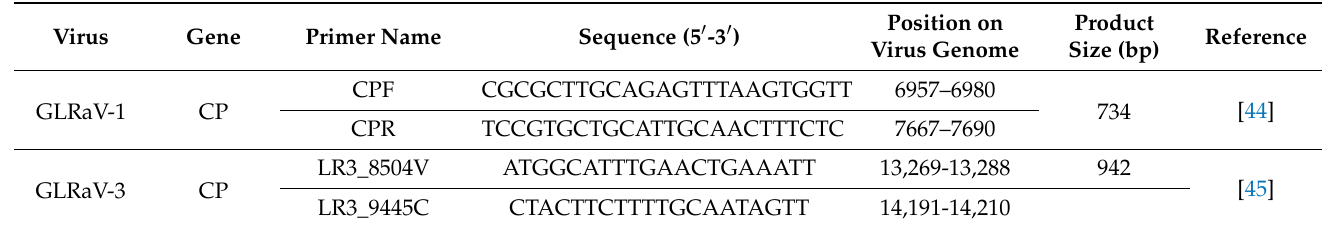
Table 2. List of primers for GLRaV-1 and GLRaV-3 specific detection by end point RT-PCR and